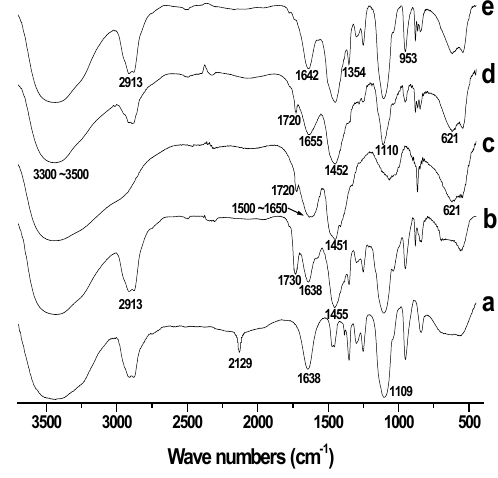
Figure 2. The IR spectra of HO-PEG-CN (a), HO-PEG-COOH (b), CS- COOH (c), HO-PEG-g-CS-COOH (d), and